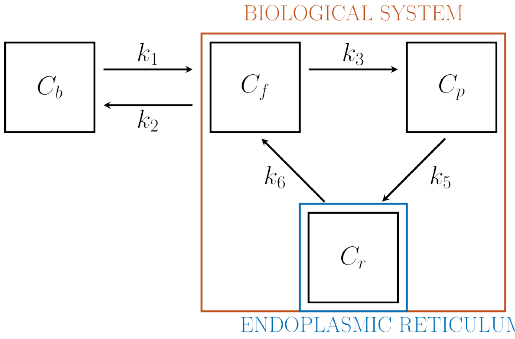
Figure 2. 3-compartment model for cell